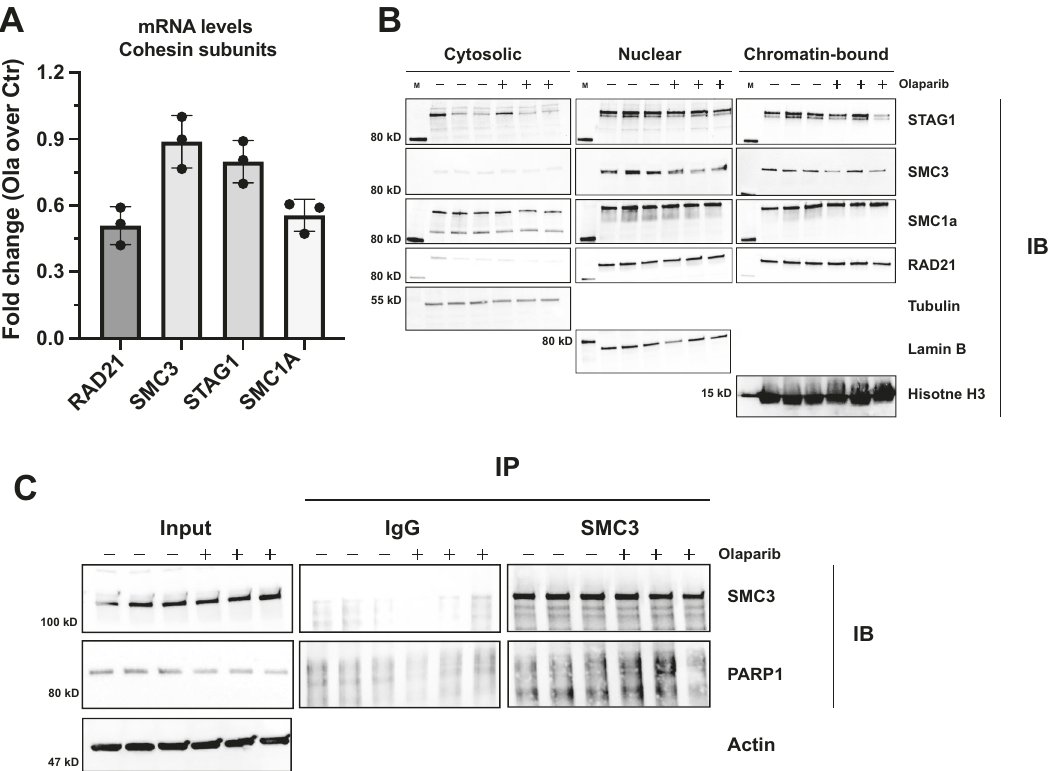
Fig. 5 Cohesin expression and localization are unchanged by PARP inhibition. A RT-qPCR of each cohesin component, each normalized to 18S, respectively, with and without olaparib treatment in LCL. Data displayed as fold change in expression of olaparib treated LCLs divided by control. The data presented is an average of three independent experiments. Source data are provided as a Source Data fi le. B Western blots of all cohesin components were independently collected from three biological replicates of control or 2.5 µ M olaparib treated LCL after subcellular fractionation. Source data are provided as a Source Data fi le. C Immunoprecipitation (IP) of SMC3 component of cohesin in three biological replicates of LCLs, with or without PARP inhibition.